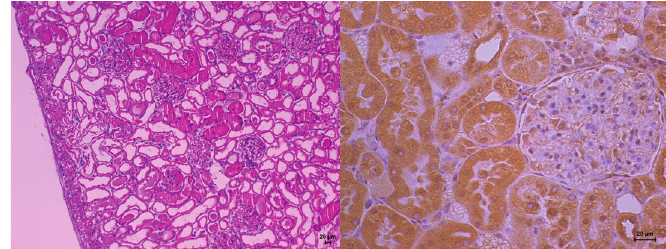
FIGURE 3 – Hematoxylin & eosin-stained histological sections (left) and immunohistochemistry – interleukin-1 (right) of rat kidneys after hemorrhage of 30% of volemia, under sevoflurane anesthesia (sevo group) plus ketoprofen (sevo+keto group) (left) Renal tubular dilation and necrosis. 10x. HE, bar=20µm. (right): intense (3+) renal tubular expression of interleukin-1. Bar=20µm. Immunohistochemistry, IL-1, ABC, DAB, contra-coloration Harris